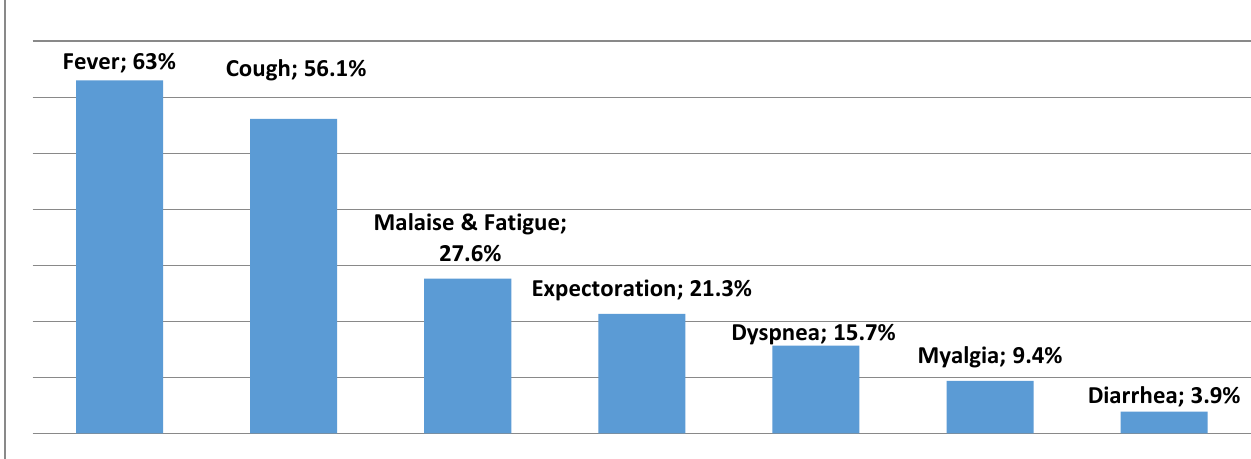
Figure 2: Non otolaryngological manifestation in COVID-19